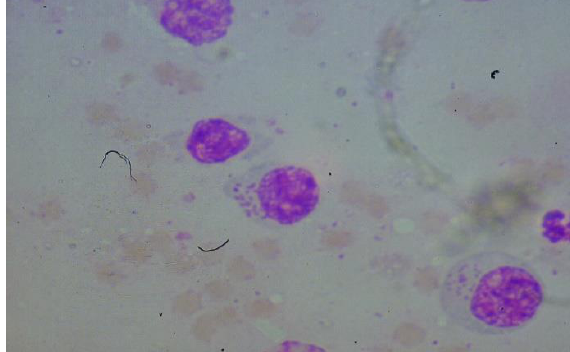
Figure, 2: Lymphocytic stage, Schizont of Theileria spp in cattle lymph smear (x 100).